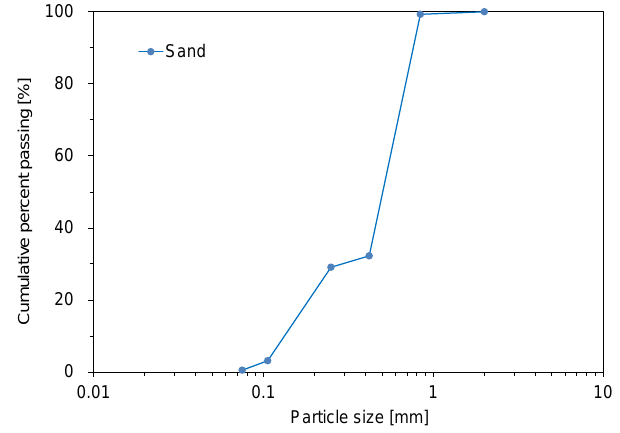
Figure 2. Particle size distribution of sand. Table 2. Mix design for CLSM used in this study.